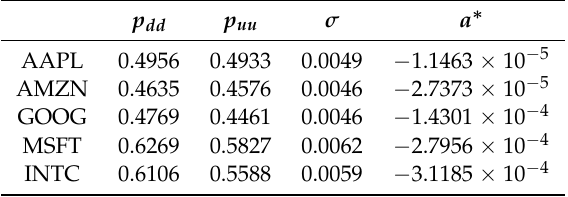
Table 4. Provided above are the values for s ∗ , σ as well as the probabilities of an upward/downward movement given an upward/downward movement for each of the five stocks in question. p